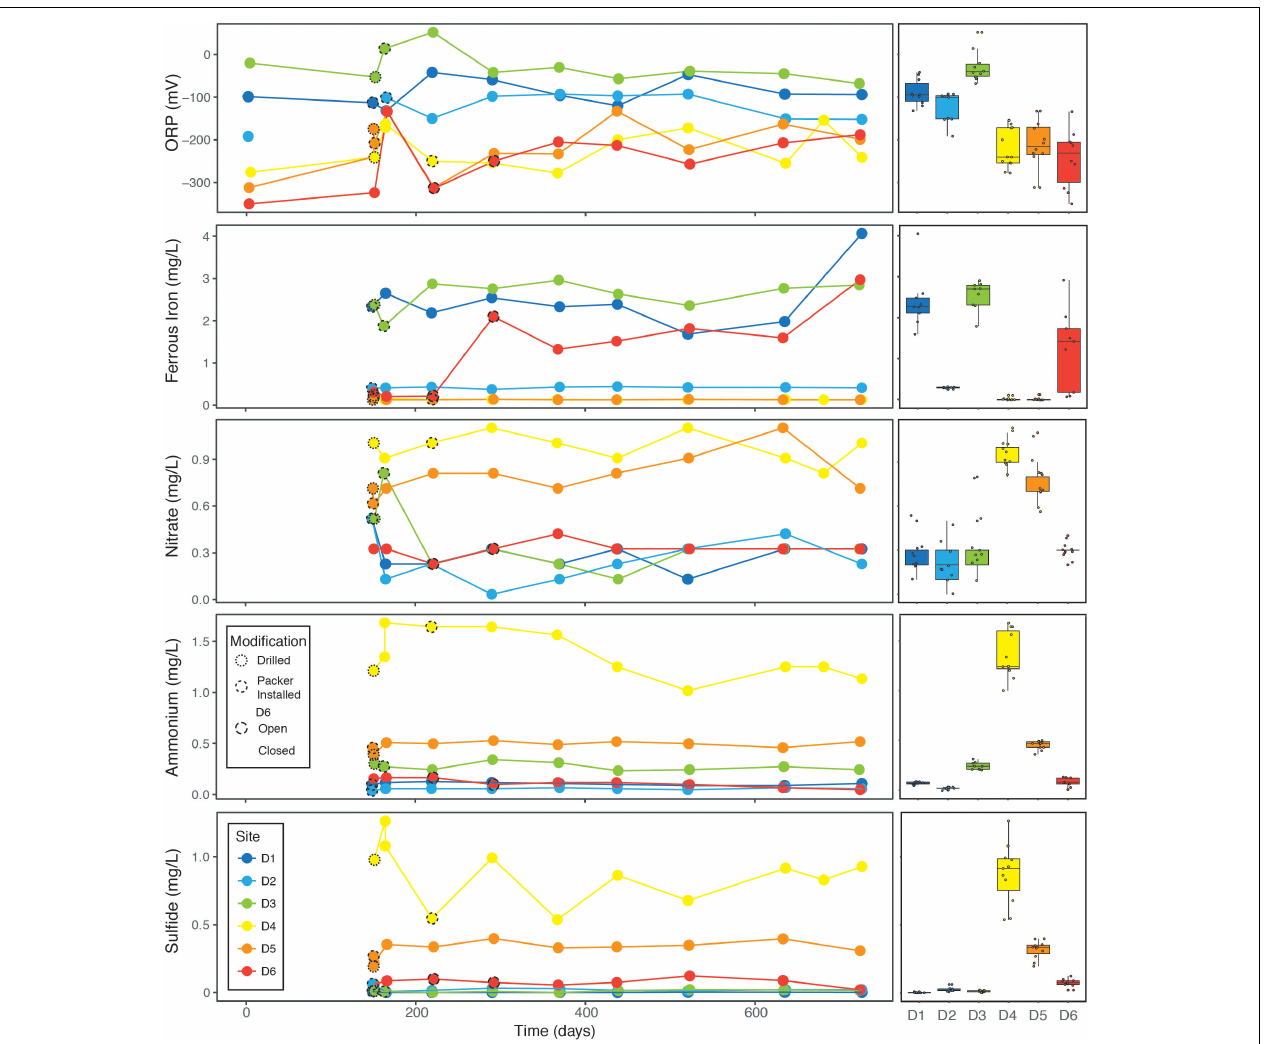
FIGURE 5 | Combined line plots and box plots of redox sensitive geochemical measurements showing change with time and aggregated site averages, interquartile ranges, and data points.